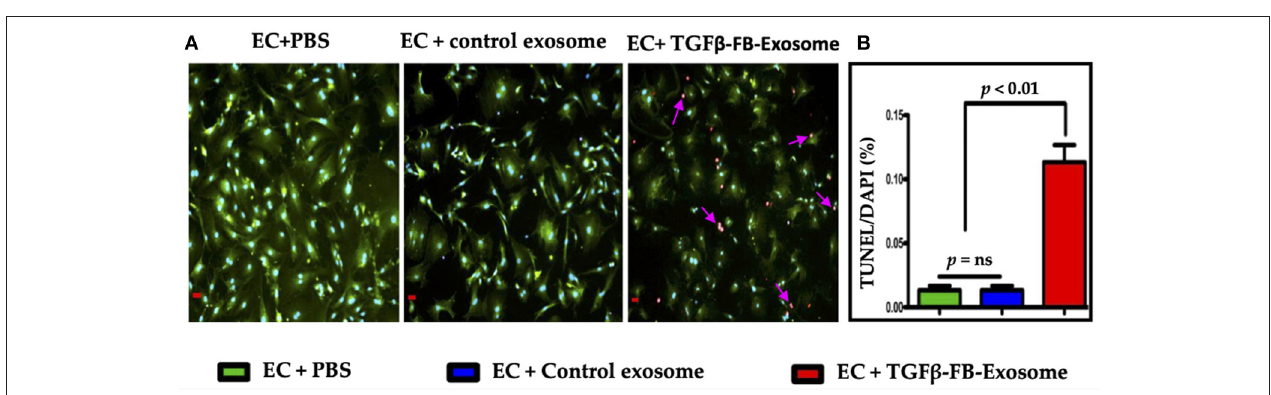
FIGURE 4 | Myofibroblasts-derived exosomes induced endothelial cell death (A,B) . Primary cardiac endothelial cells were isolated from the C57BL/6 mice and were treated with exosomes derived from TGF β -treated fibroblasts for 48h. TUNEL staining was performed in 4% PFA fixed cells as per manufacturer’s instruction. ECs were counterstained with CD31/PECAM (green; EC surface marker) antibody. Images (A) were taken at 400X and scale bar is 100 µ m. P < 0.05 vs. control exosome and PBS treatment. ( Figure 7E ). Our data suggest that by altering fibroblast content the corresponding scramble group ( Figure 7D ). Treatment of using molecular tools, we can alter the parent cell-derived ECs with exosomes from the altered FBs reflected a similar exosomal reduction in miR-200a-3p content in corresponding ECs